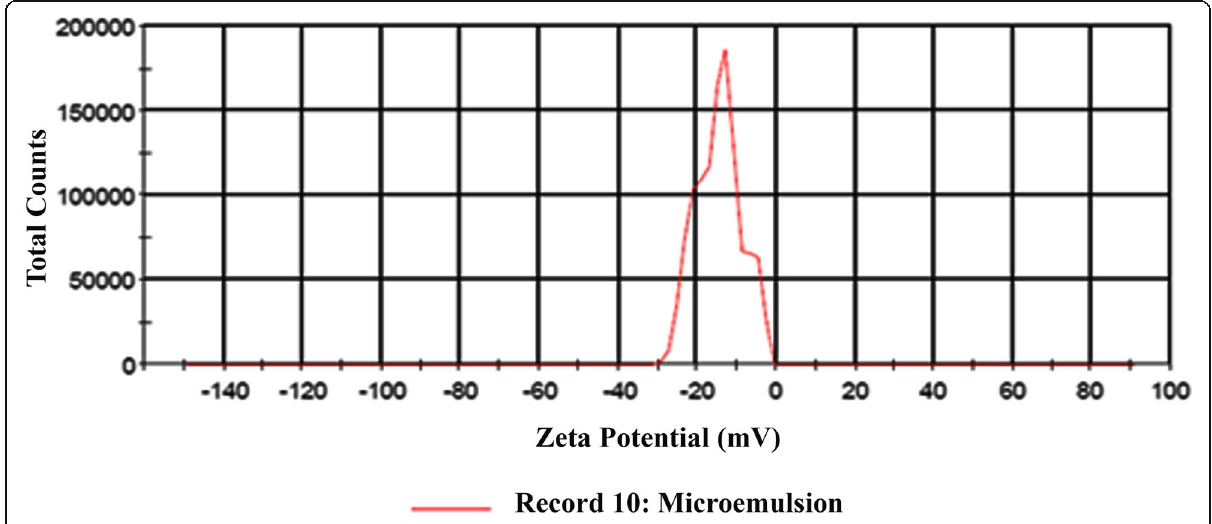
Fig. 4 Zeta potential measurement of microemulsion